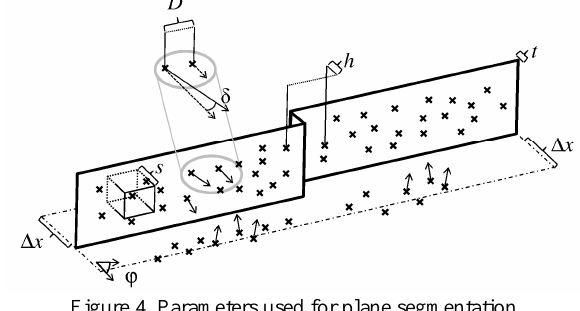
Figure 4. Parameters used for plane